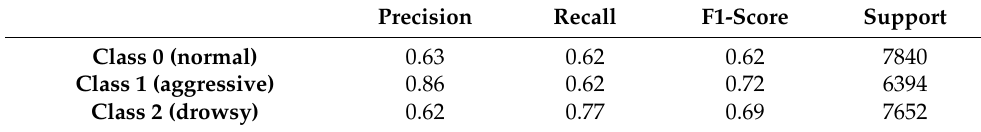
Table 6. Multi-class evaluation metrics with gradient boosting classifier for traffic